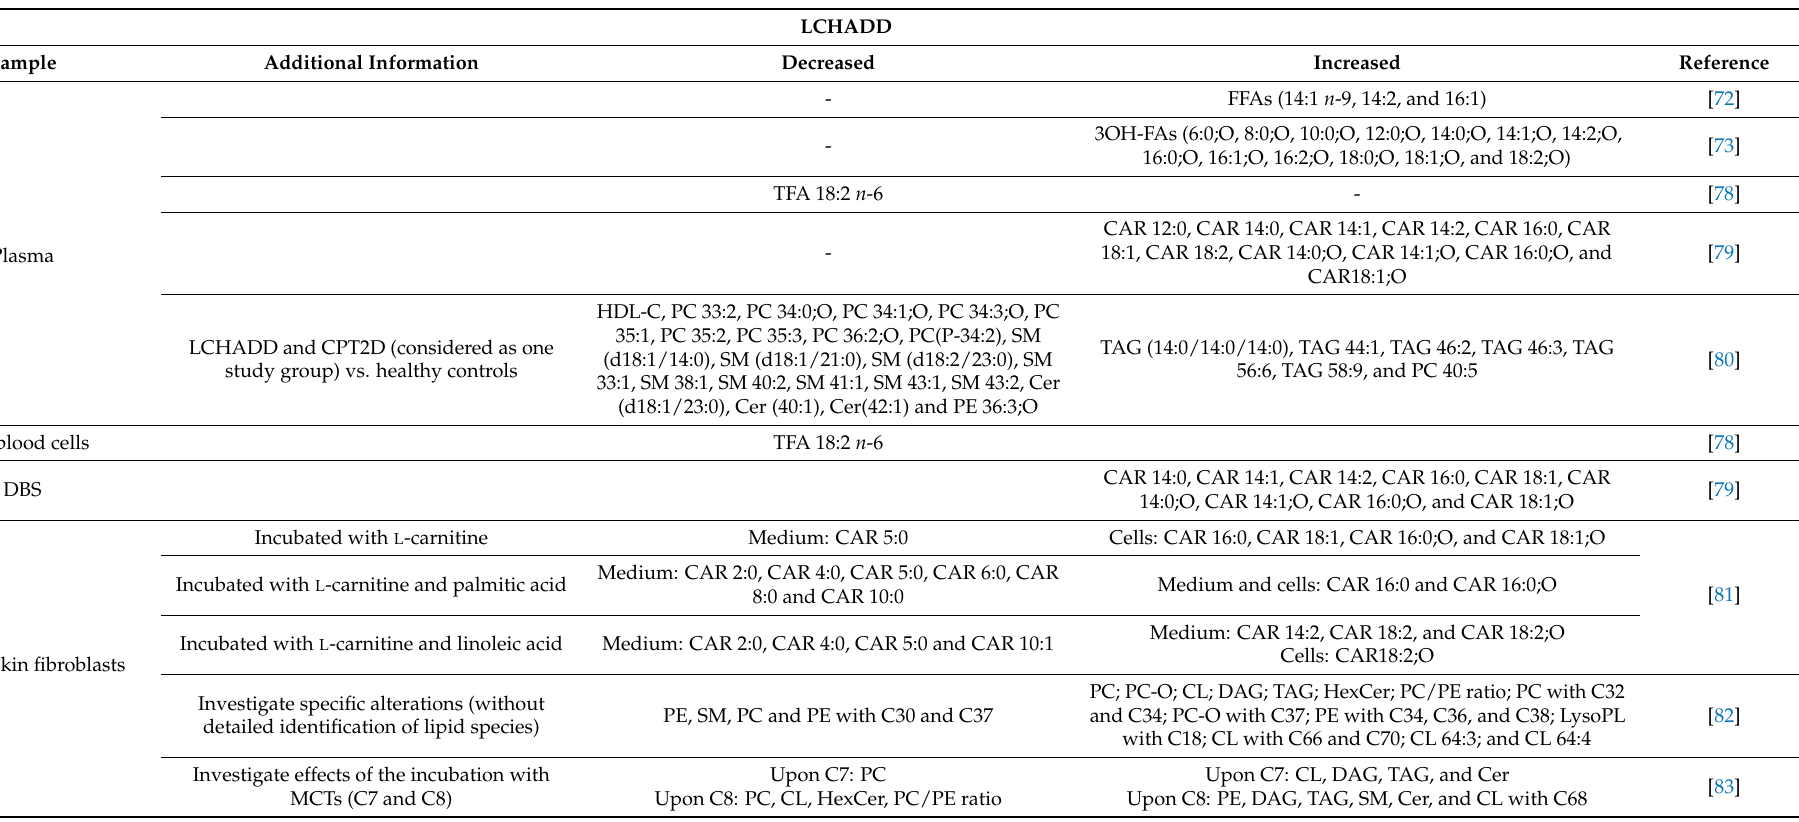
Table 3. Main changes in the lipid profile of plasma, red blood cells, dried blood spots (DBSs), and skin fibroblasts of long-chain hydroxy acyl-CoA dehydrogenase deficiency (LCHADD) patients reported in published